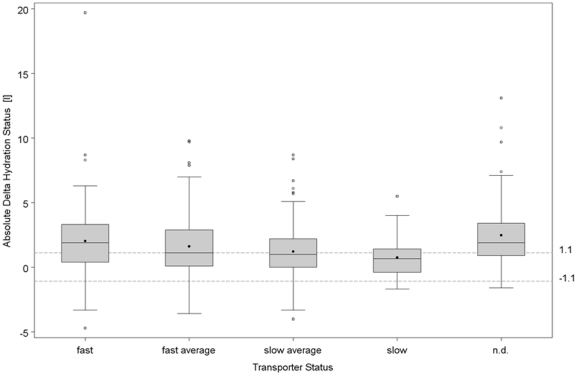
Box and whisker plots (median, 25th and 75th quartile, outliers) of Absolute ΔTissue Hydration (in liters) in the different transport categories.n.d.: no peritoneal transport characteristics available in the 4 months before the BCM measurement.